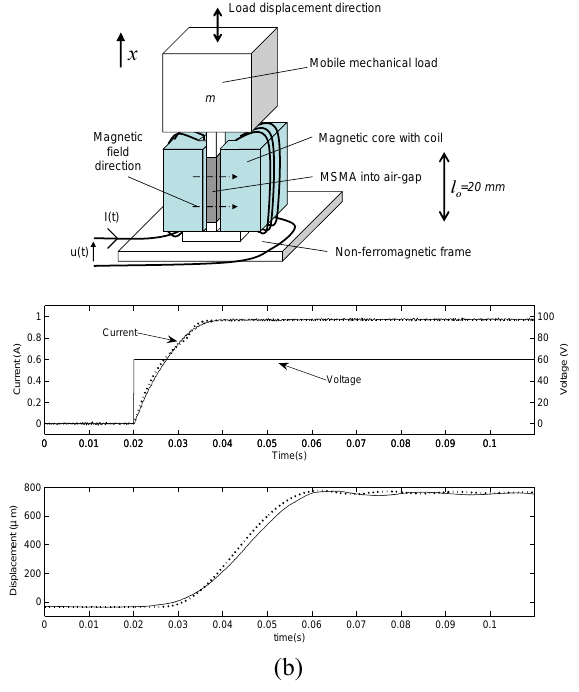
Figure 4: (a) description of a simple MSMA actuator, (b) dynamic behaviour of the system: voltage, current and dis- placement vs time (simulation: dotted line and experimen- tal results: solid line)